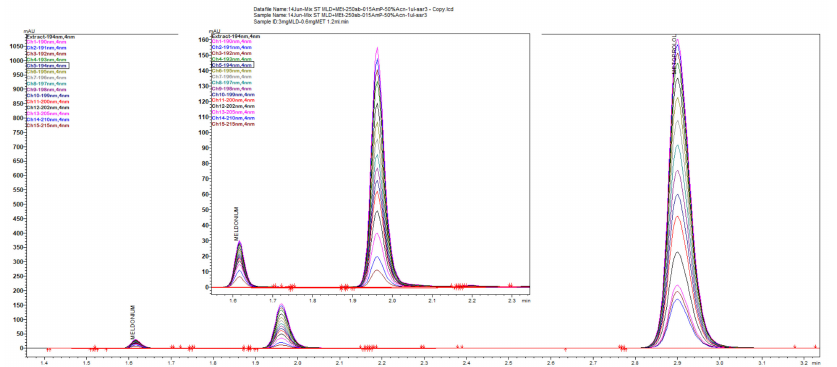
Figure 29. Chromatograms with Zorbax CN-SB-250 × 4.6 mm with 50% ACN and 50% 13 mM (0.15% w / v ) NH 4 H 2 PO 4 and overlaid 15-channels of different UV-absorbing wavelengths, with expanded zoomed peak of meldonium inserted for better comparison with metoprolol